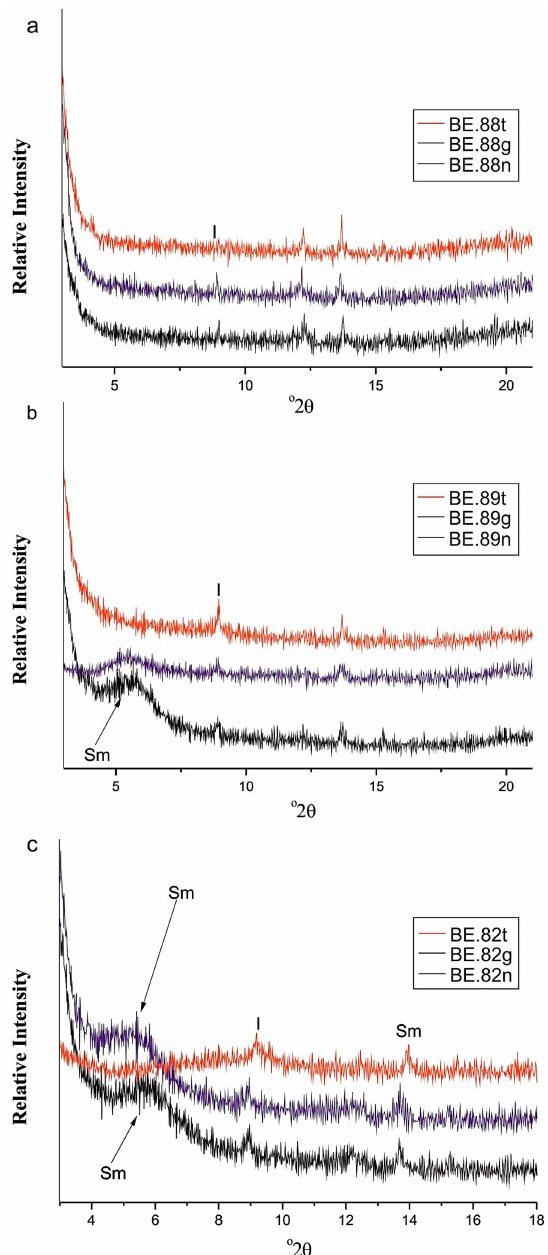
Figure 5. X-ray diffraction patterns of the clay fraction from three andesite samples: ( a ) sample BE.88; ( b ) sample BE.89; ( c ) sample BE.82. Sample numbers are given in the insets (n: air dried, g: glycolated, t: heated, Sm: smectite, I: